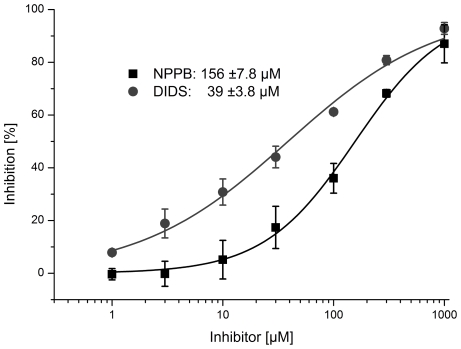
Inhibition of ClC-7.Several putative Cl− channel inhibitors were tested for inhibition potency (Tab.1). ClC-7 was activated with 30 mM Cl− concentration jump while different concentrations of inhibitors (1–1000 µM) were present in all buffers. The plots show mean inhibition values and standard deviation of at least 3 independent experiments (5 measurements per concentration each). The data was fitted with a Hill function, yielding IC50 values of 39±3.8 µM (Hill coefficient n = 0.6) for DIDS and 156±7.8 µM (Hill coefficient n = 1.0) for NPPB.